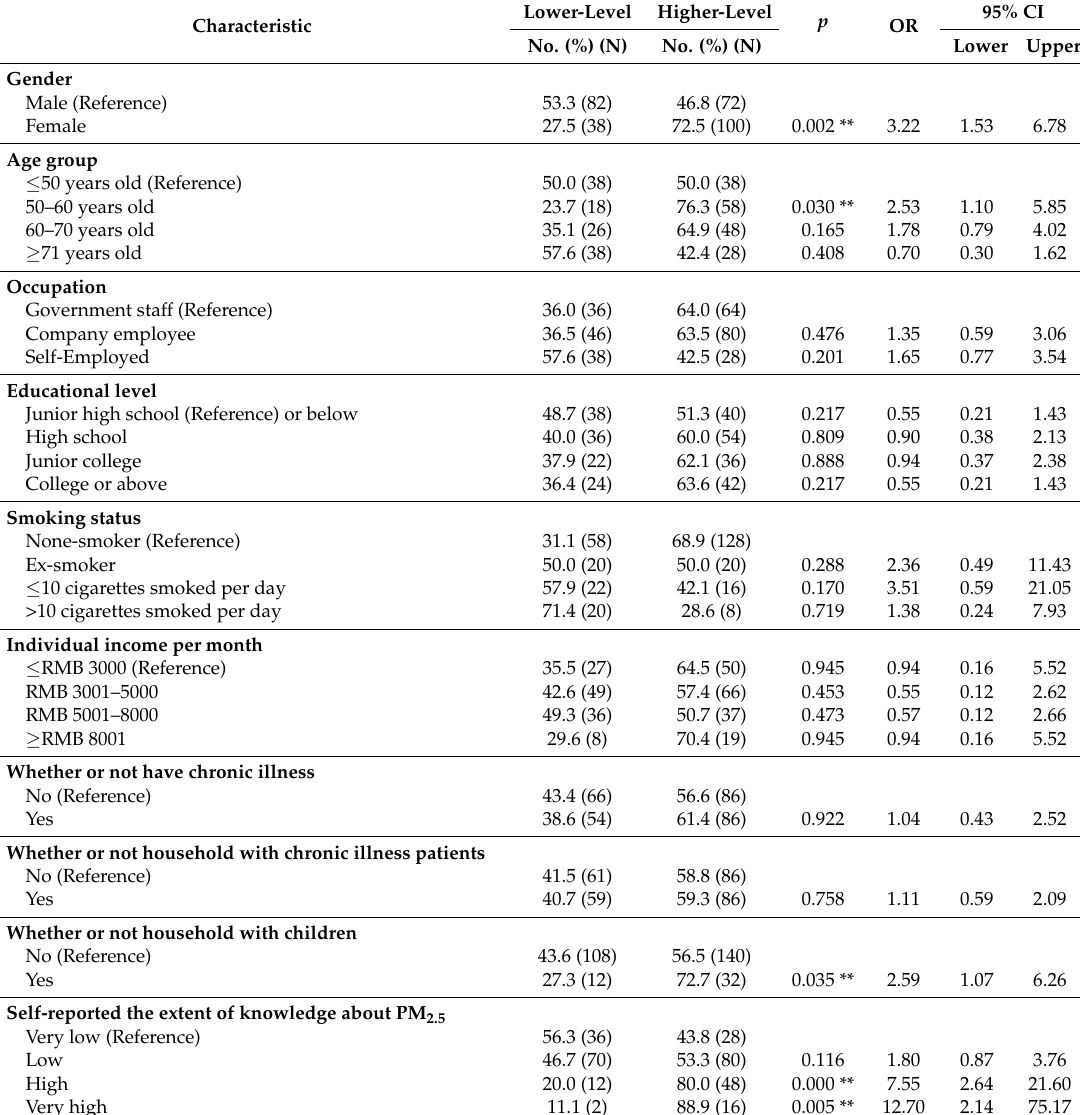
Table 3. Outcome of multivariate logistic regression analysis (mean value as cutting point) for factors that influence the adoption of risk reduction behavior regarding PM 2.5 (N =